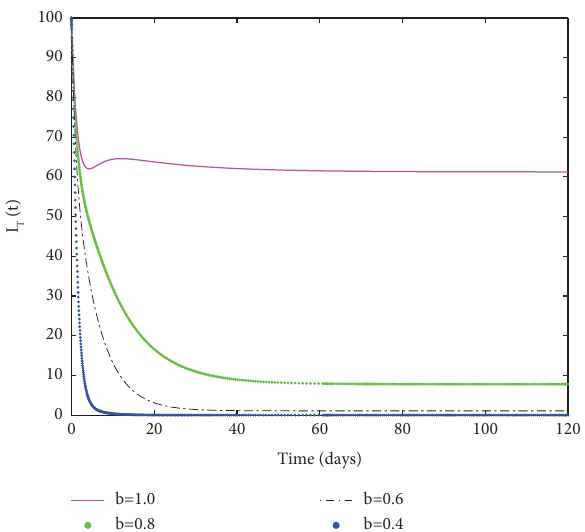
Figure 4: Behaviour of the active TB infected individuals at diferent values of b